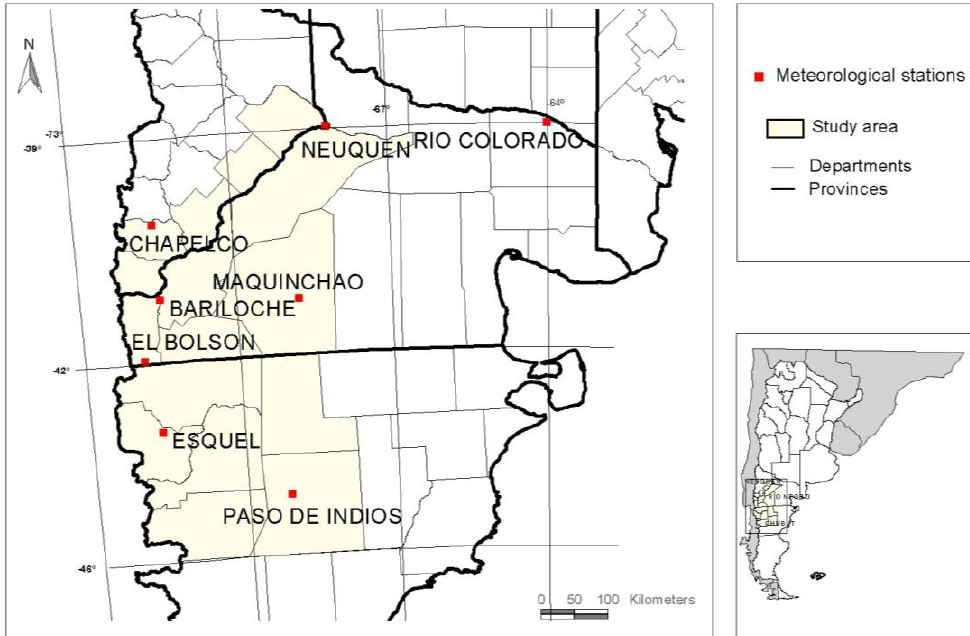
Figure 2. Location of the meteorological stations used in this work. [Realized by the